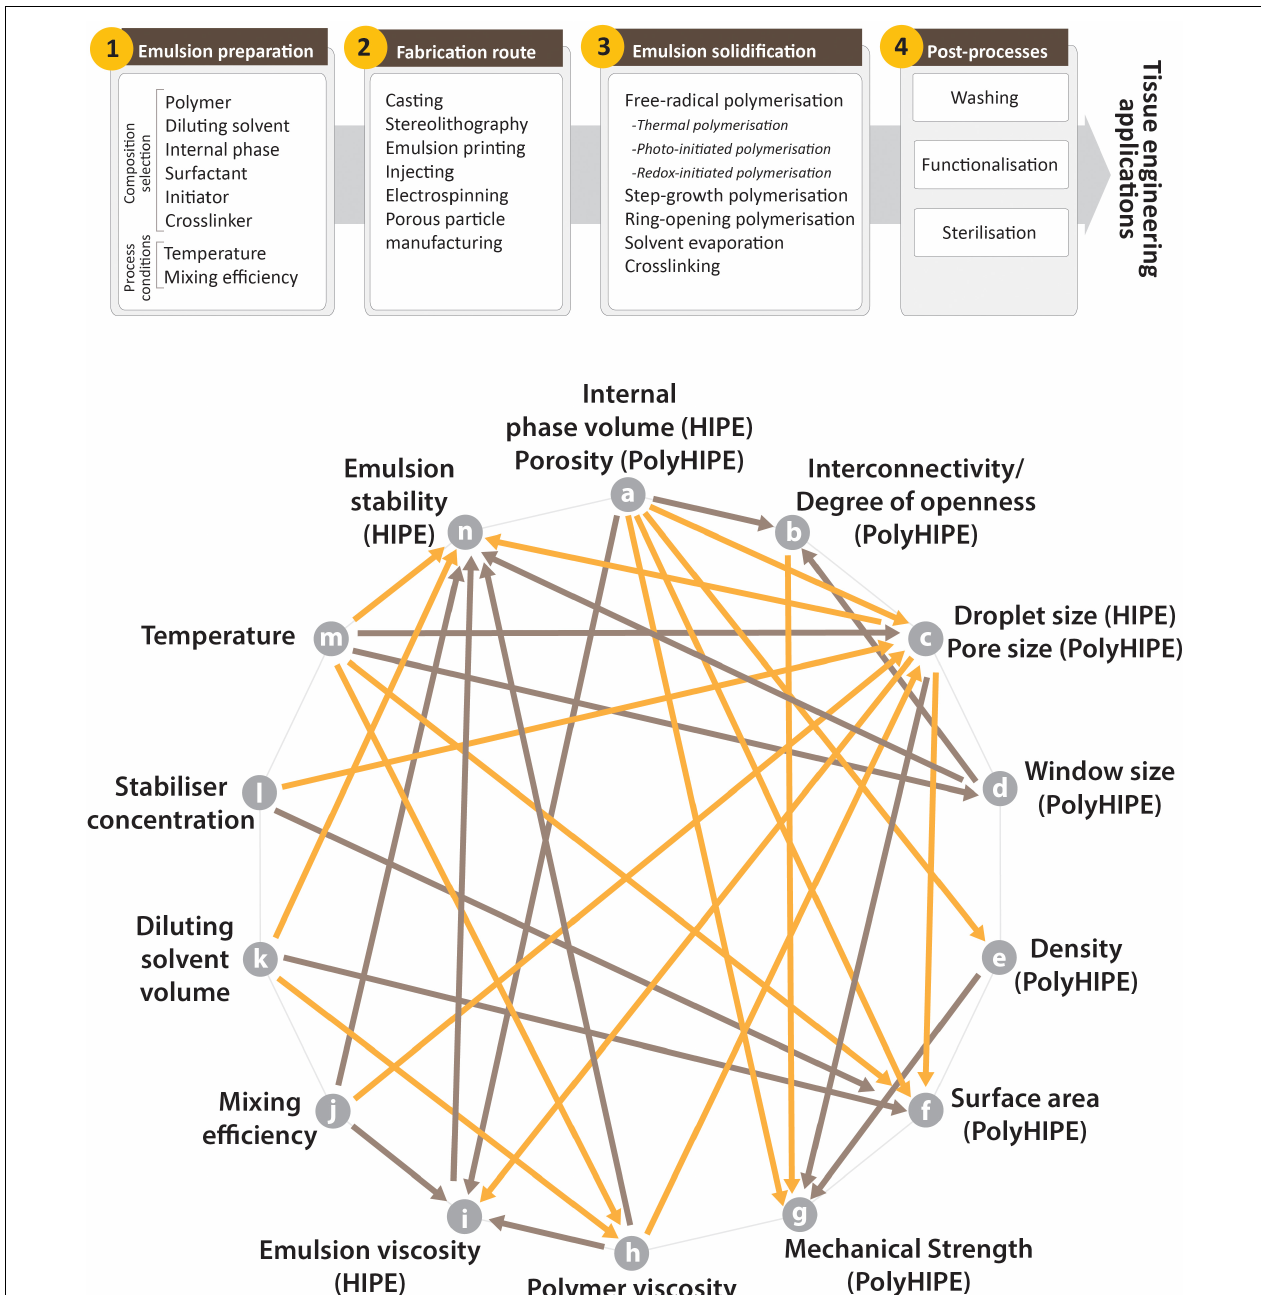
FIGURE 7 | (Top) Steps of manufacturing of the emulsion templated substrates, (Bottom) commonly seen relations of the characteristics of HIPEs and PolyHIPEs and some of the process conditions (orange arrows indicate one-way reciprocal proportionality, brown arrows indicate one-way direct proportionality. For